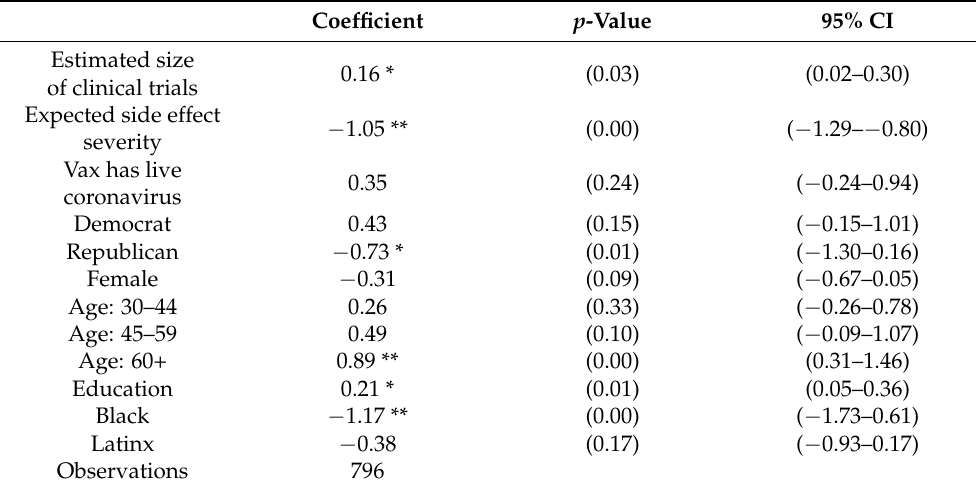
Table 3. Associations between misconceptions, demographics, and willingness to vaccinate.